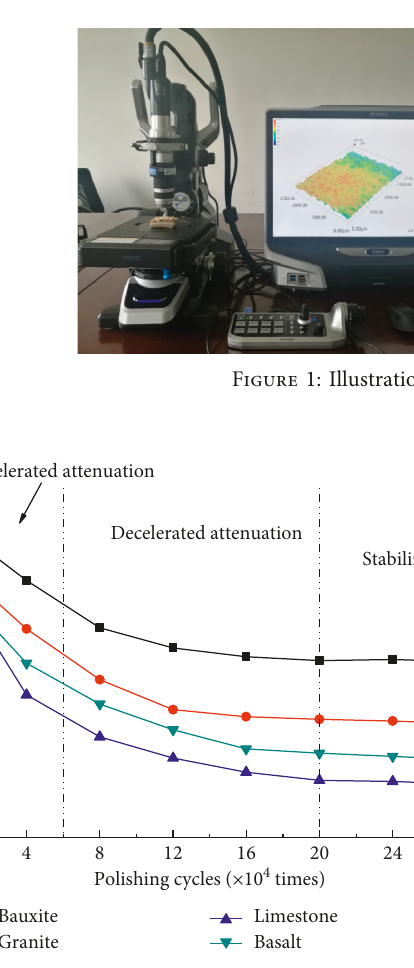
Figure 2: Variation of PSV during the long-term polishing process.